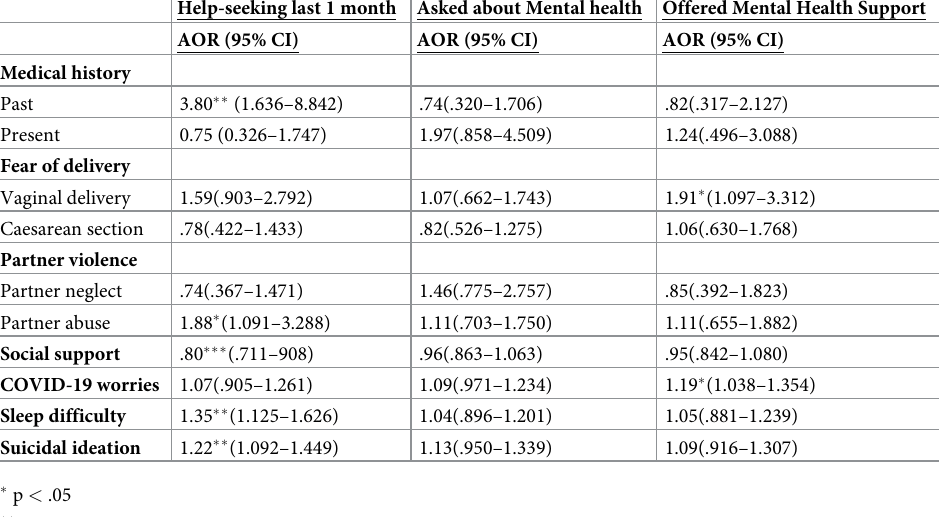
Table 5. Predictors of mental health help-seeking, controlling for individual predictors and demographic